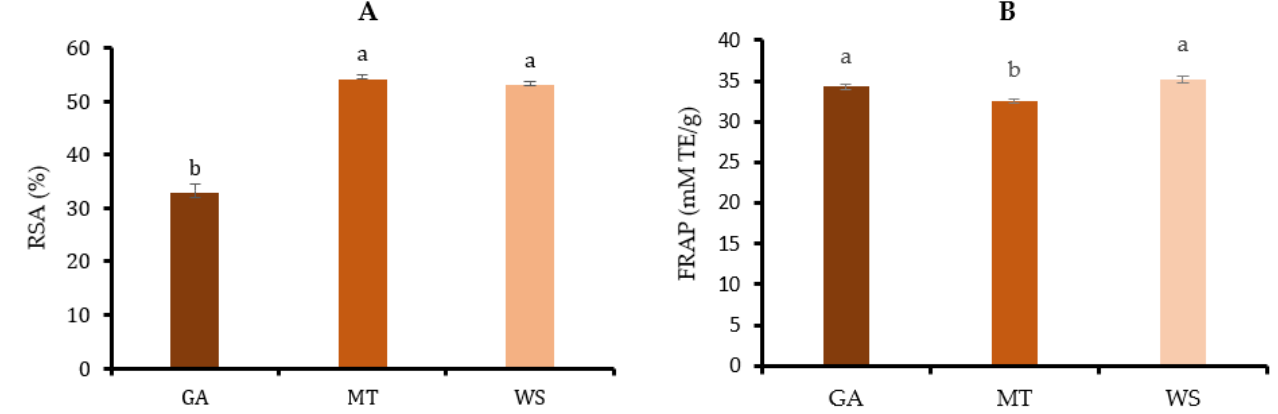
Figure 4. ( A ) Radical scavenging activity, and ( B ) Ferric reducing antioxidant power of raspberry juice powders developed using different carriers. Bars followed by different letters are significantly different ( p < 0.05) according to Duncan’s multiple range test. Vertical bars indicate the standard deviation of the mean. GA—gum Arabic; MT—maltodextrin; WS—waxy starch.